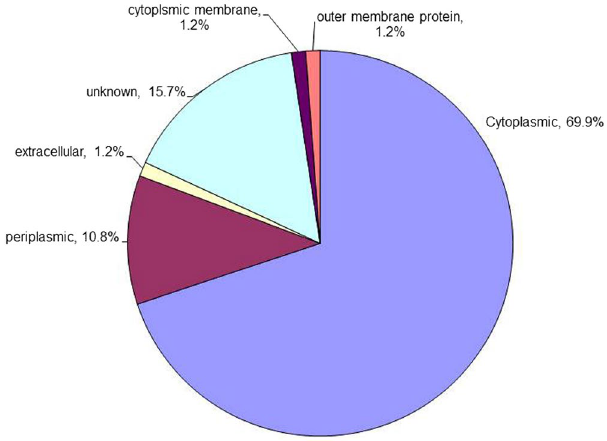
Figure 3. Subcellular localisation of differently expressed Bp MARAN and Bp mouse-adapted proteins. The subcellular localisation categories were predicted using